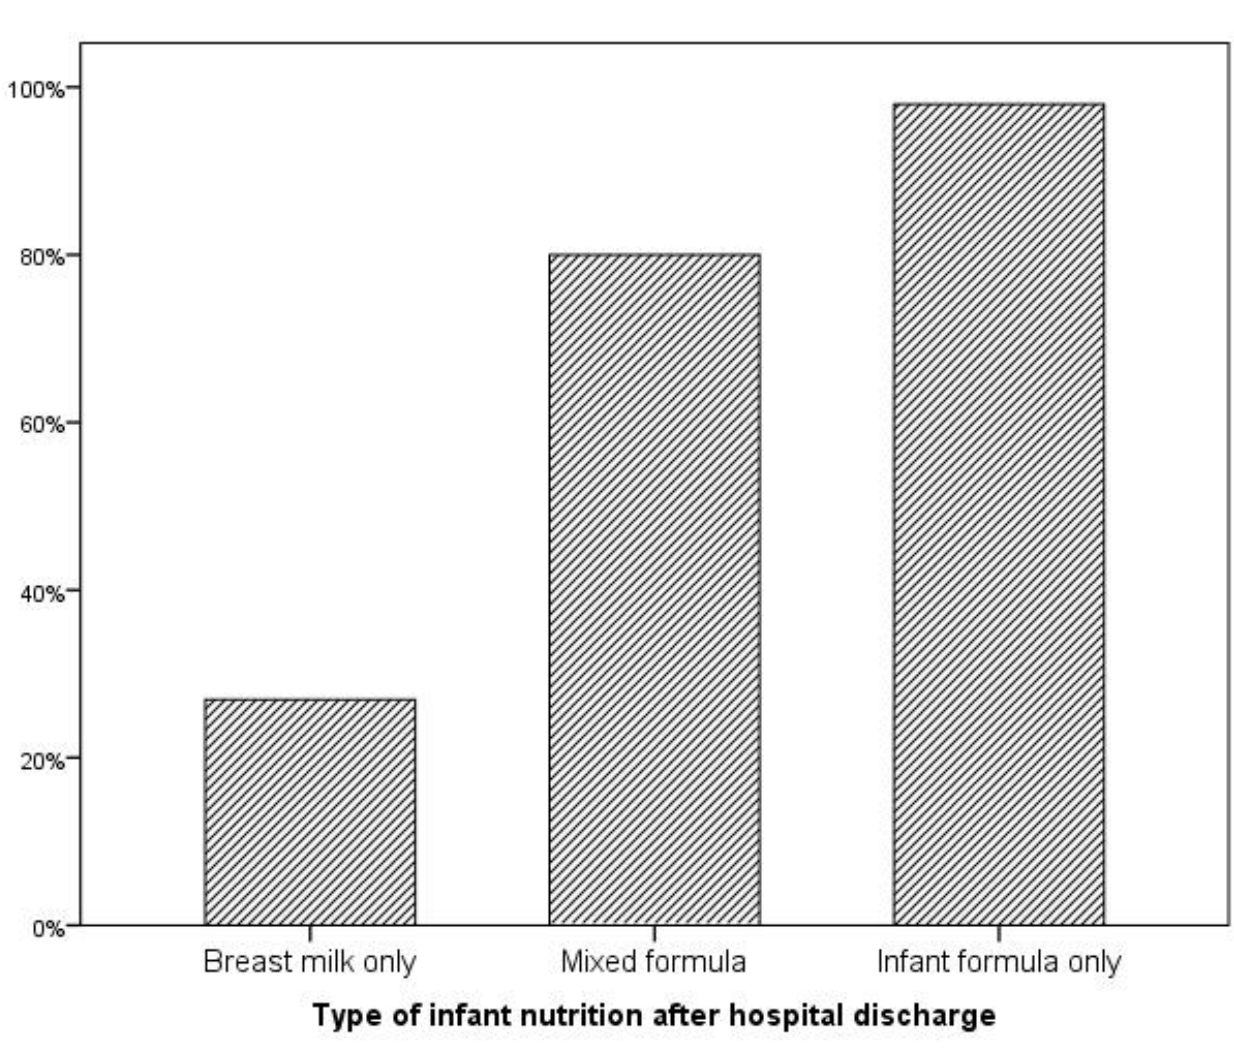
Figure 1. Infant nutrition after hospital discharge according to reported difficulties in breastfeeding.